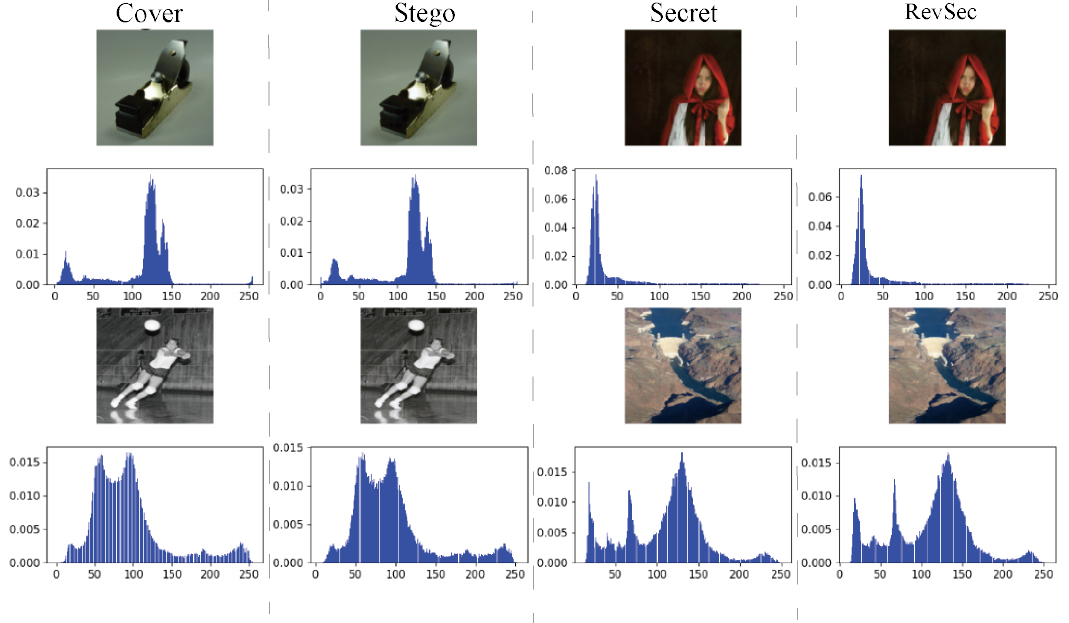
Figure 7. Random histogram test of two sets of experimental data.